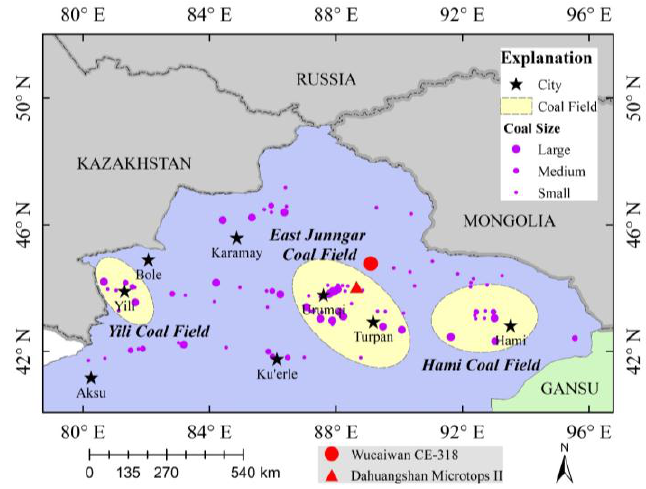
Figure 1. Map of the study area and the two ground-observed sites. Table 1. The detailed information of sites and instruments.